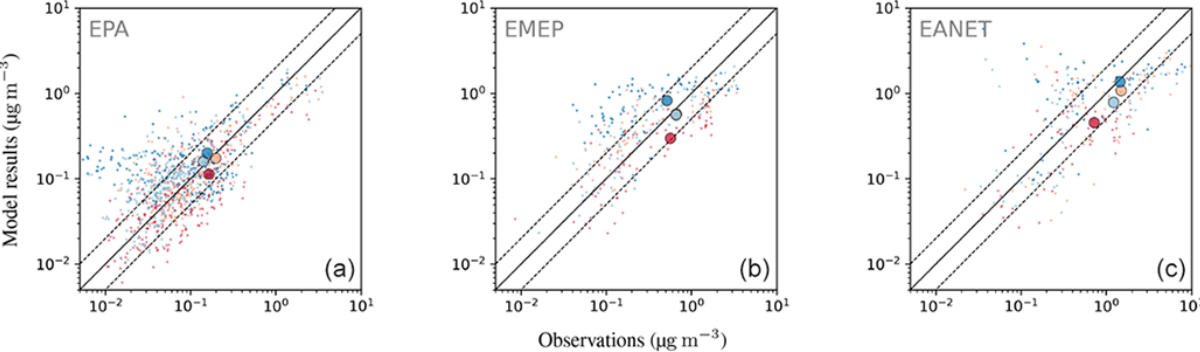
Figure 27. The same as Fig. 20 but for Na + .